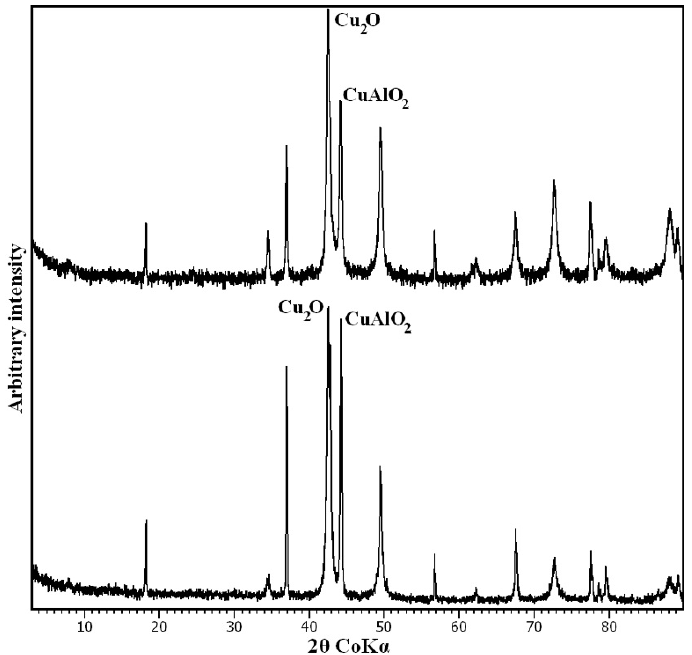
Figure 6. PXRD pattern of LDH 3CuAl·SO 4 -pH8 (below) and LDH 3CuAl·SO 4 -pH10 (above) after heating at 1400 °C. Only the main maximum for every phase is labelled.